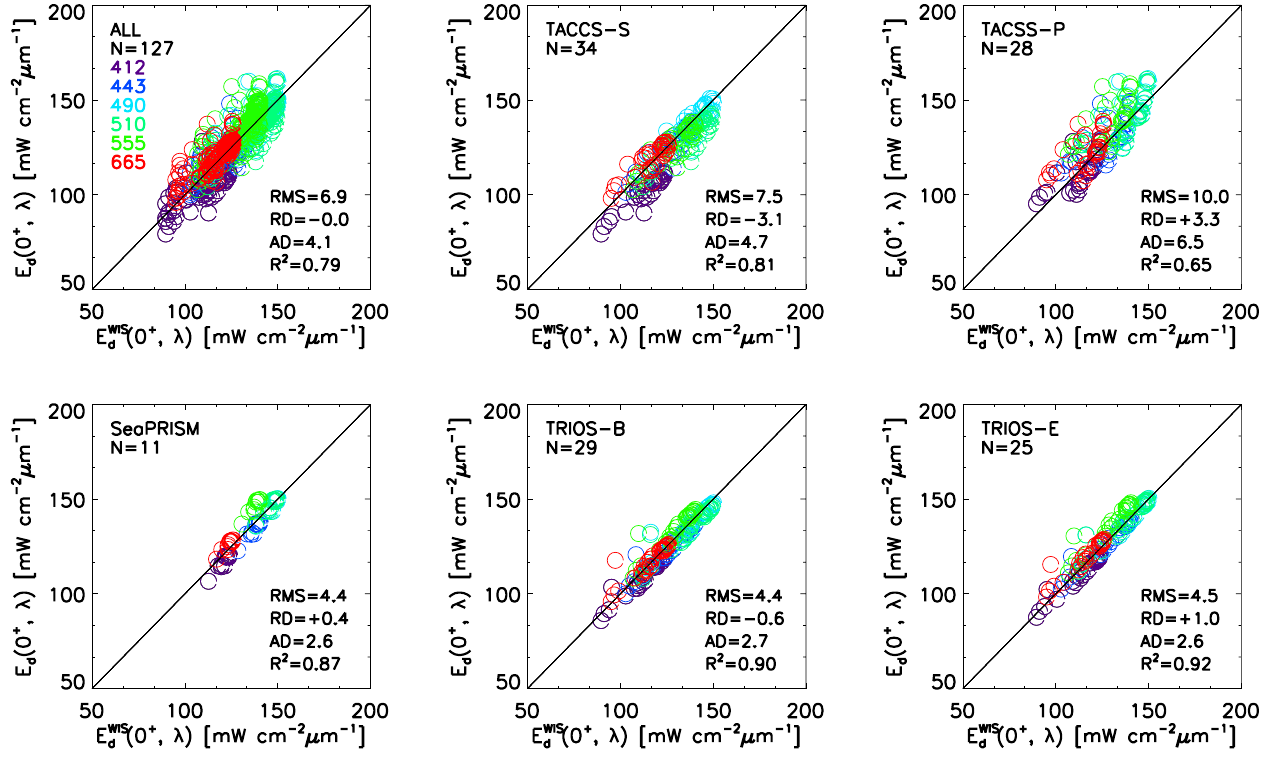
Fig. 3. As in Fig. 2 but for E d (0 + , λ)